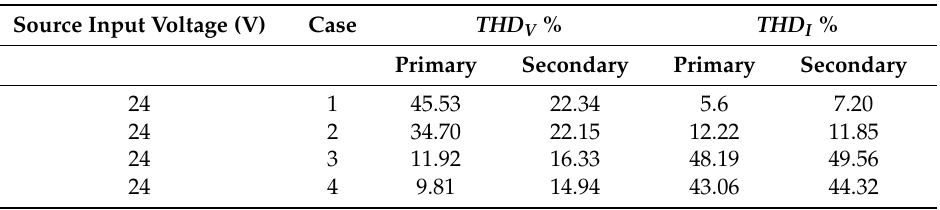
Table 6. Voltage and current THD for all